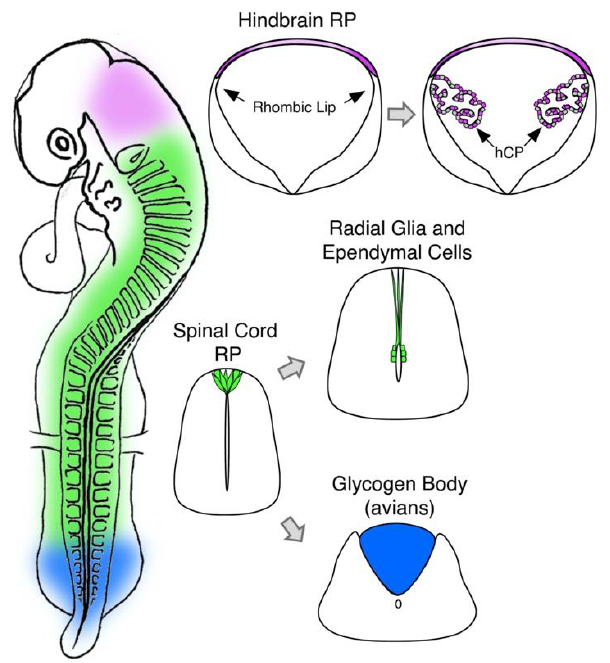
Figure 3. Differential properties of the RP at various axial levels. The hindbrain RP (purple) forms as an enlarged sheet of squamous epithelial cells bordered by the rhombic lip epithelium. The lateral domains of the hindbrain RP generate choroid plexus cells (hCP). The RP at spinal cord levels (green) is initially composed of pseudostratified epithelial cells, which are later transformed into